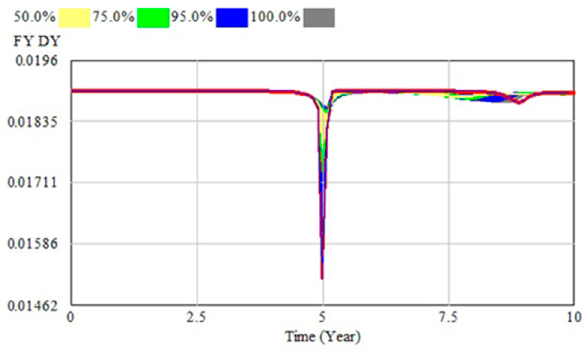
Figure 27. SD sensitivity trace range of ‘detection’